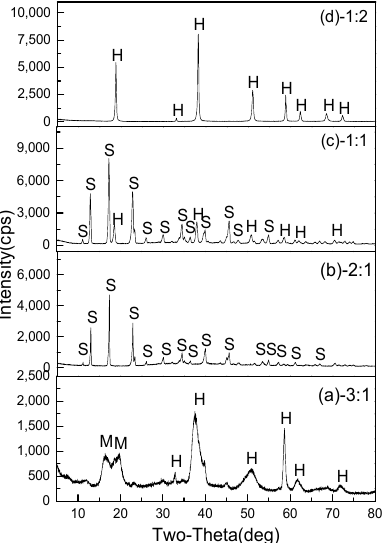
Figure 10. XRD patterns of whiskers obtained at different MgSO 4 /NaOH mole ratios (H-Mg(OH) 2 , S-5Mg(OH) 2 ·MgSO 4 ·2H 2 O, M-MgSO 4 ·xH 2 O).